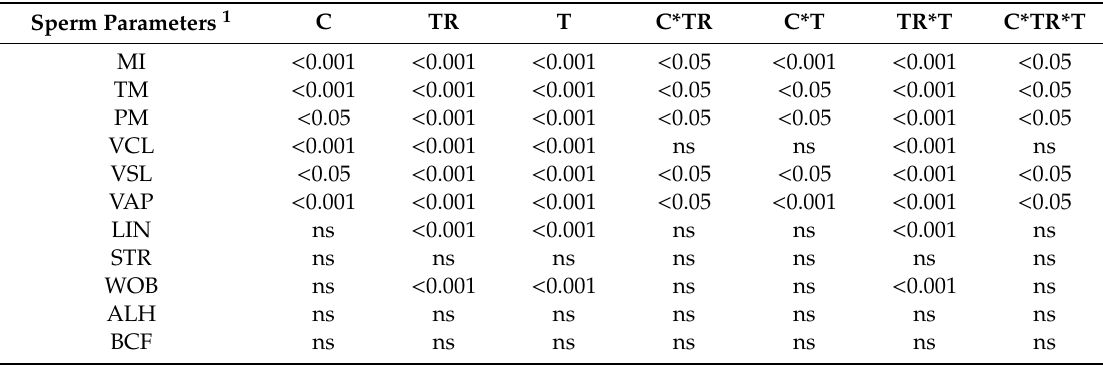
Table 1. Results of Analysis of Variance: p values of the sources of variation cryoprotectant concentration (C), thawing rate (TR), time of sampling (T) and the relative interactions included in the statistical General Linear Model applied to study chicken sperm quality before and after cryopreservation. Sperm Parameters